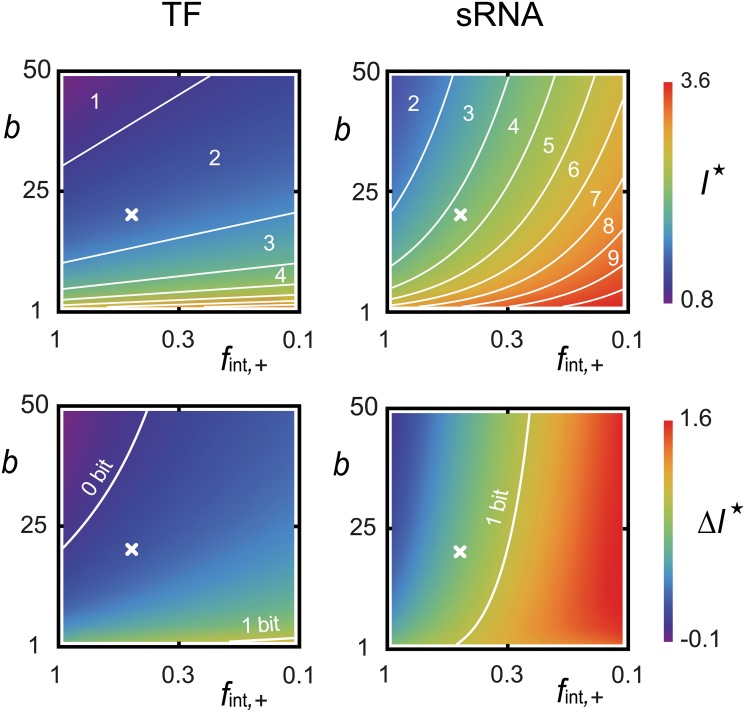
Optimal MI and optimal MI increase.Dependence of the optimal MI I
⋆ and the optimal MI increase ΔI
⋆ (in bits) on the burst size b and on the level of self-repression f
int,+ (in logarithmic scale) for both TF and sRNA regulations. The Xs indicate the values f
int,+ = 1/2 and b = 20 for which Table 1 was computed. In the top panels, the white curves are isoinformation curves separating regions where the optimal quorum-sensing channel can discriminate the indicated number of cell-density ranges. In the bottom panels, the white curves represent parameters for which feedbacks cannot improve information transfer (0 bits) or can double the number of distinguishable cell density ranges (1 bit). Note that, in both cases, a decrease in f
int,+ has to be matched by a larger bare MP output rate to ensure the boundary condition τmfint,+fm(1)(a+)=m+. Parameter values: ρ
+/ρ
− = 104, a
− = 0.1nM, a
+ = 1mM, m
− = 100nM, m
+ = 600nM, f
int,− = 2, K = 15nM, h = 2 and v = 1μm3.